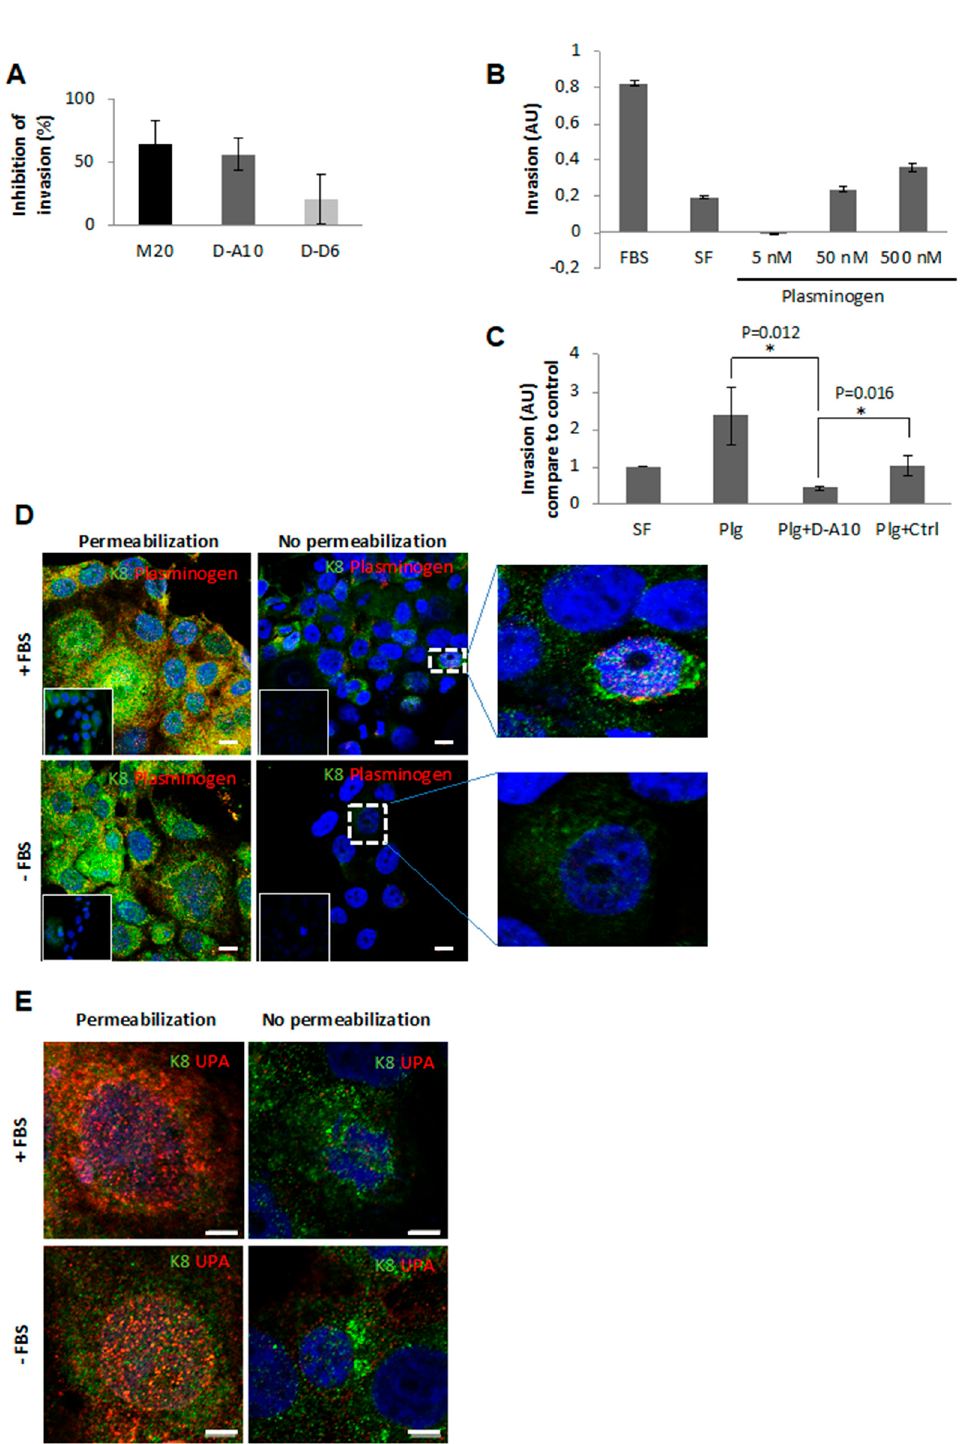
Figure 1. Plasminogen-induced invasion is externalized form of cytokeratin 8